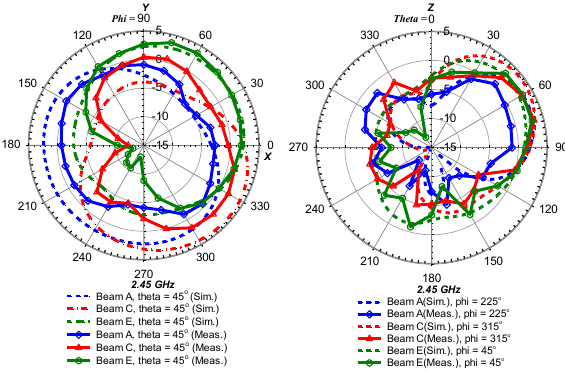
Figure 16: Simulated and measured radiation patterns of beams B and D.